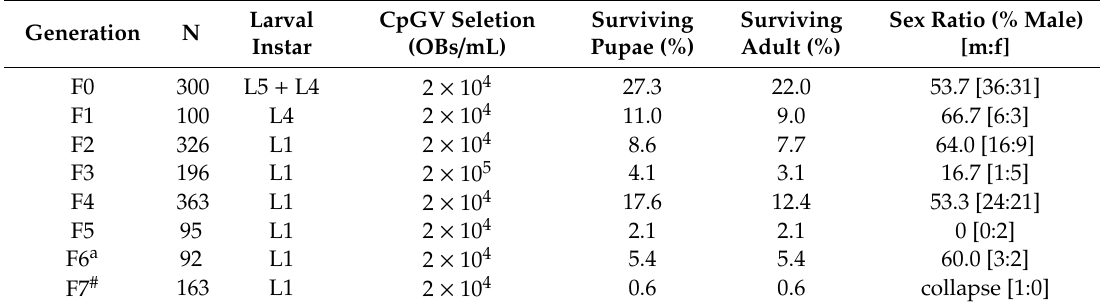
Table 1. Survival and adult sex ratio of CpRR1 progeny at each selected generation. The number [N] and instars of larvae used in each selection step, the percentage of surviving pupae and adults of each treatment, and the percentage of resulting males including the numbers of males and females [m:f] of surviving adults are